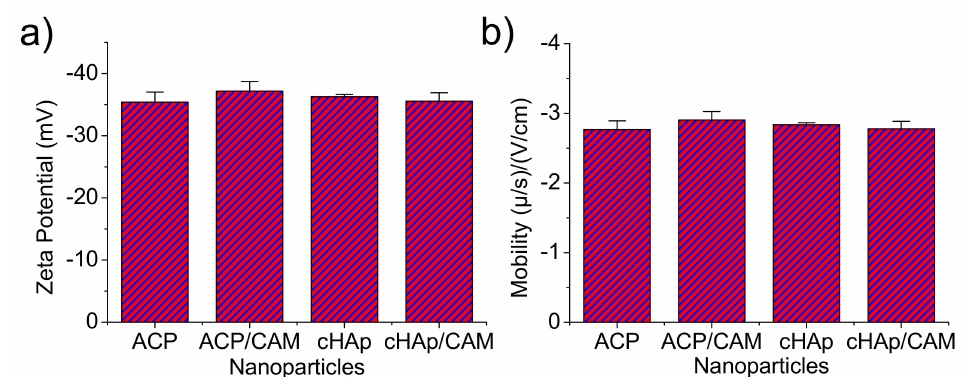
Figure 6. Zeta potential ( a ) and electrophoretic mobility ( b ) of the indicated unloaded and CAM loaded